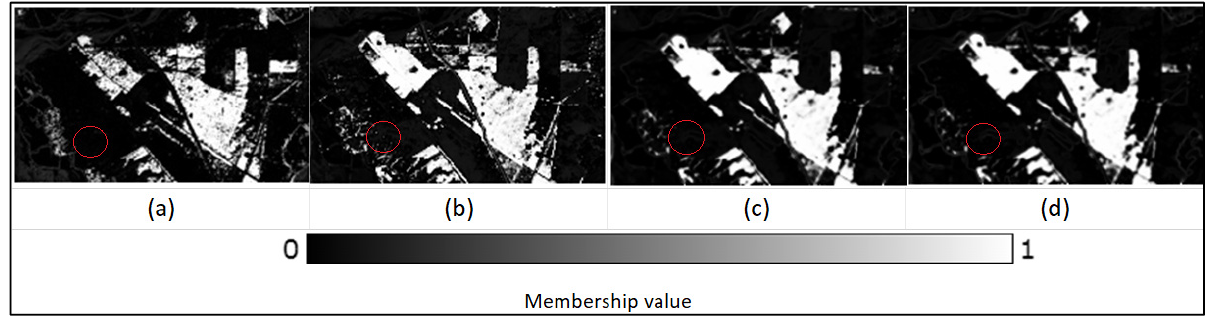
Figure 11. Example of fuzzy local spatial information classifiers in removing isolated pixels: ( a ) Reference fraction image for ‘Eucalyptus’ class, ( b ) FCM classifier output fraction image with isolated pixels, ( c ) FCM-S classifier output fraction image where isolated pixels are handled, and ( d ) FLICM classifier output fraction image where isolated pixels are handled.